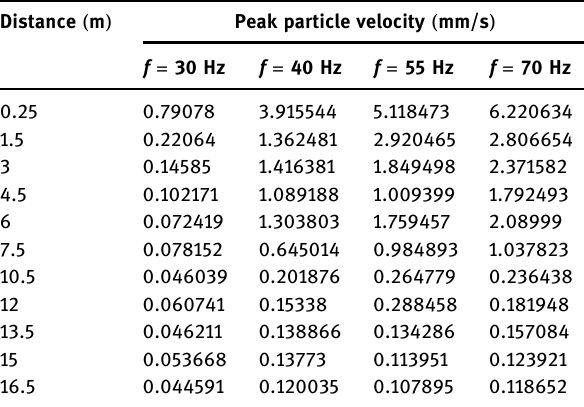
Table 13: The measured peak particle velocities at di ff erent loca - tions for various frequencies ( passive in - fi lled with 40% rubber trench barrier )